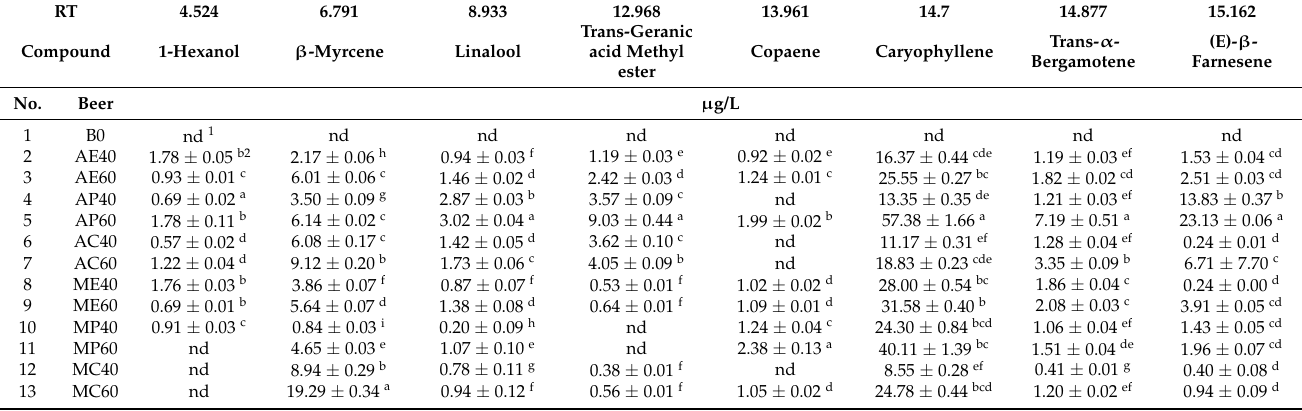
Table 2. Hop volatile compounds.